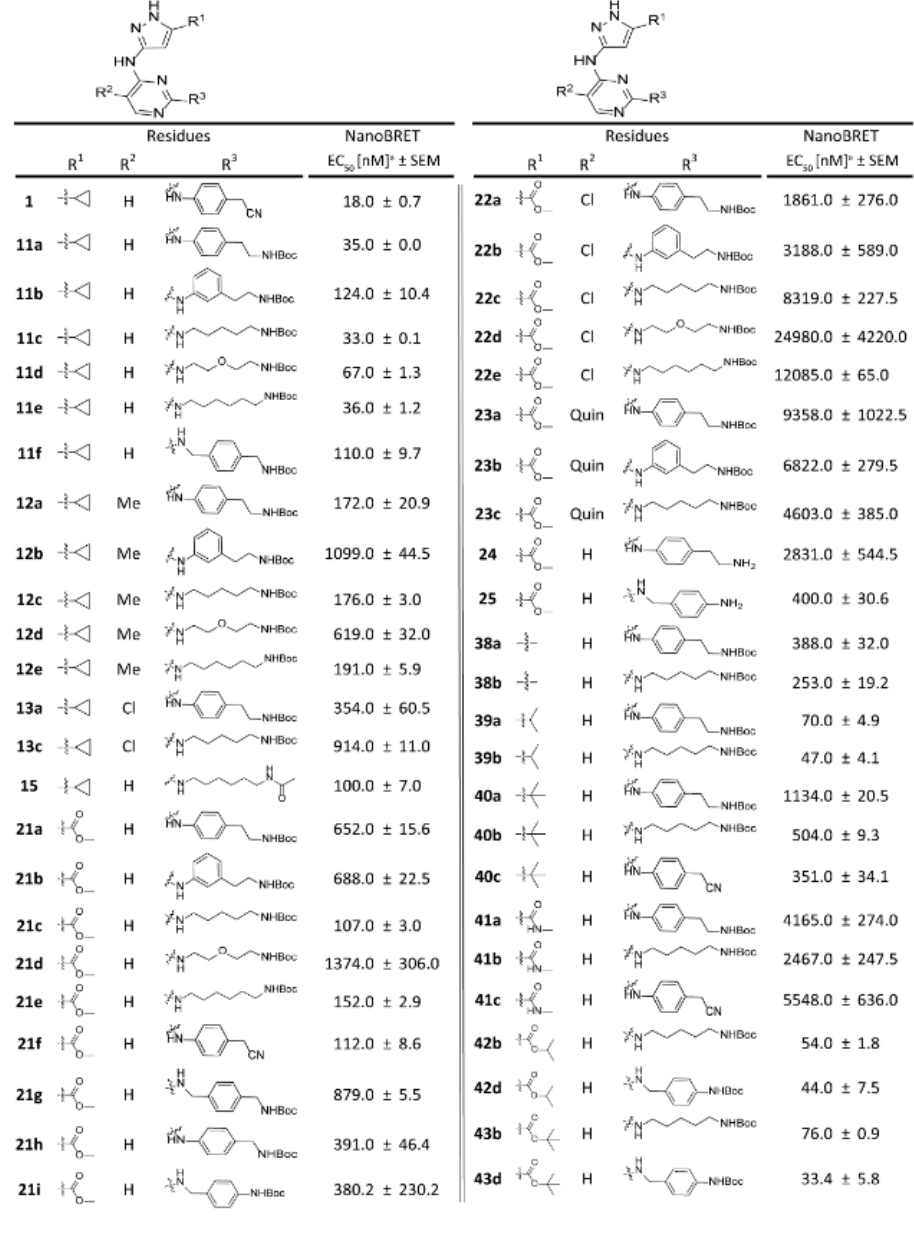
Figure 7. Overview of the binding affinities of the N -(1 H -pyrazole-3-yl)pyrimidine-4-amine-based inhibitors against CDK16. a EC 50 values were determined using the NanoBRET assay in a 11-point dose − response curve in duplicates.